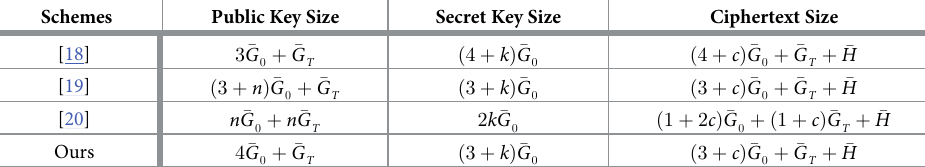
Table 3. Comparison of communication